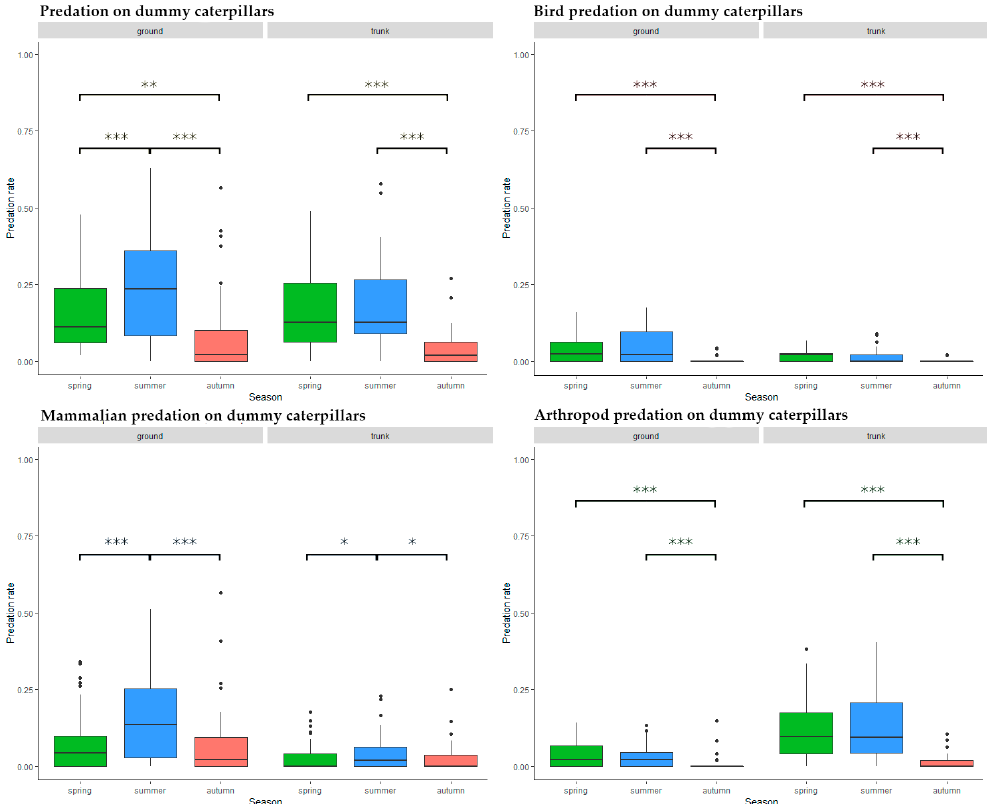
Figure 4. Predation activity along the urbanization gradient on different placement and by Figure 5. Predation activity during the season on di ff erent placement and by di ff erent predator groups. Significance codes: ***: p < 0.001, **: p < 0.01, *: p < 0.05,